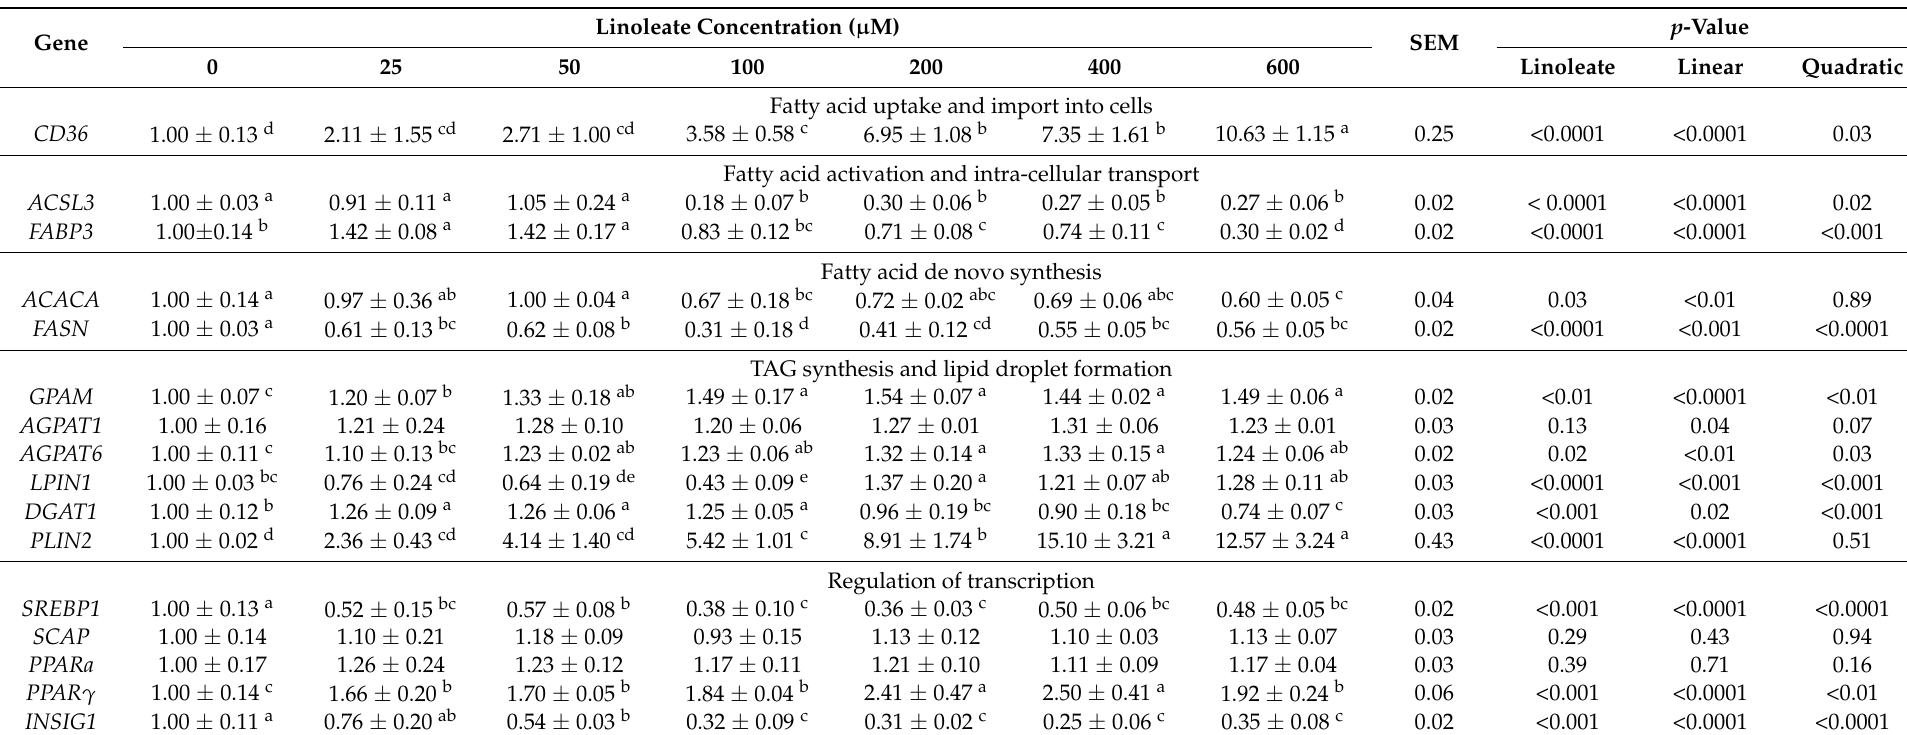
Table 3. Effect of linoleate on mRNA expression of genes involved in lipid synthesis in pMECs 1